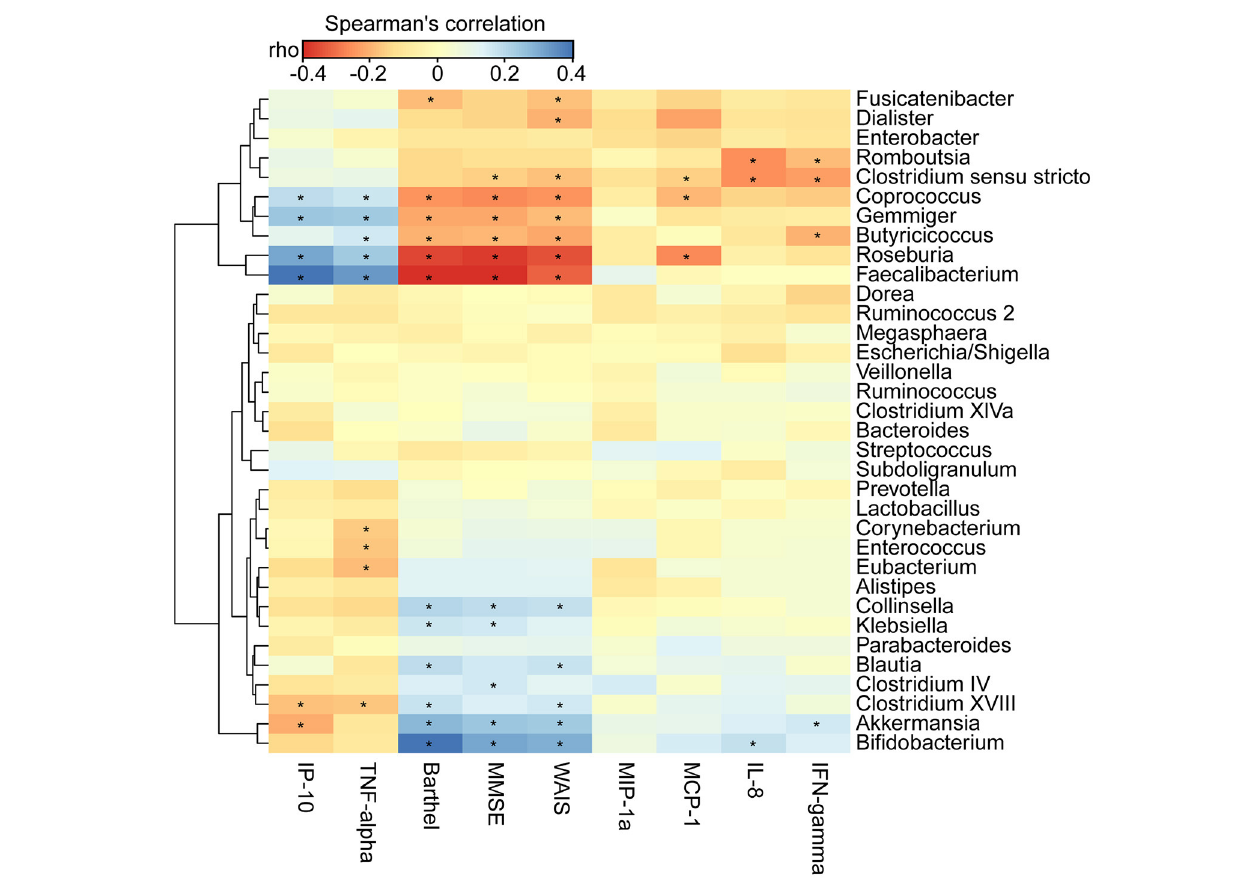
FIGURE 6 | Correlation between fecal microbiota, and pro- and anti-inflammatory cytokines and chemokines and clinical indicators. The heatmap shows partial Spearman’s correlation coefficients between 34 genera, and clinical indicators and host immunity in AD patients. Spearman’s rank correlation (r) and probability (p) were used to evaluate statistical importance. * p <